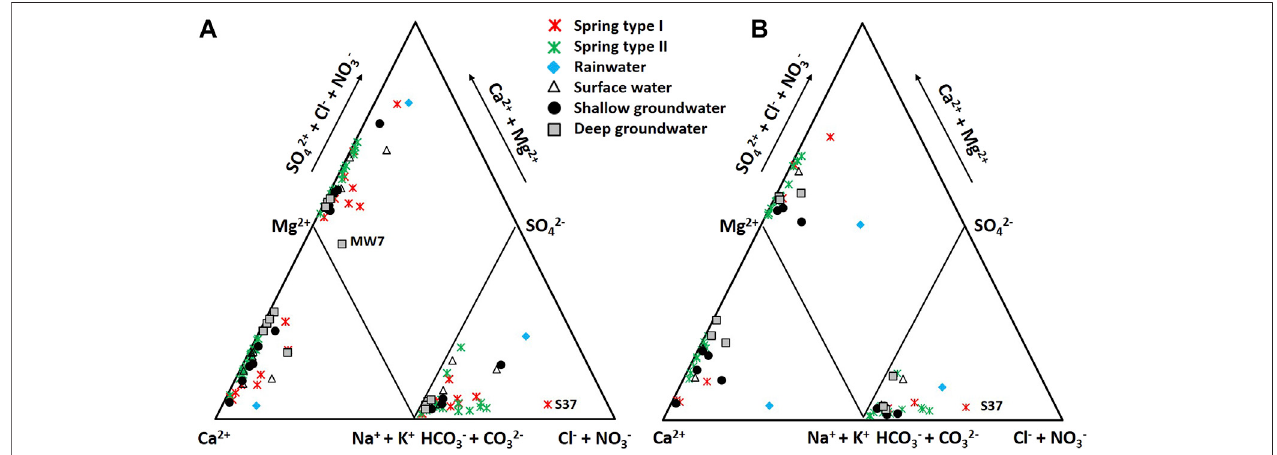
FIGURE3 | Piper ’ s diagram with NO 3 − on theCl − axis showing the hydrochemical characteristics ofvariouskinds of water groups collected during the dry season (A) and rainy season (B) in 1999. The letters on the diagram indicate the names of distinct samples.